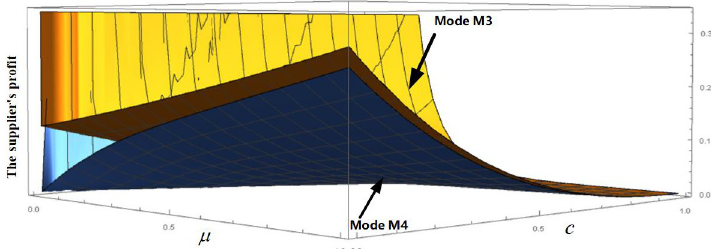
Fig 5. The supplier’s profit of supplier or retailer to implement CM with endogenous wholesale